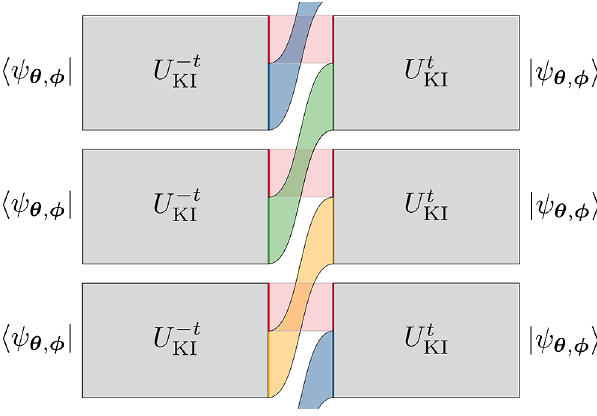
FIG. 4. Schematic representation of tr ½ð ρ the expression (31). The six different cylinders corresponding to the partition functions (38) are schematically represented as rectangles. The spin subchains A and A c connected with the colored belts share identical spin